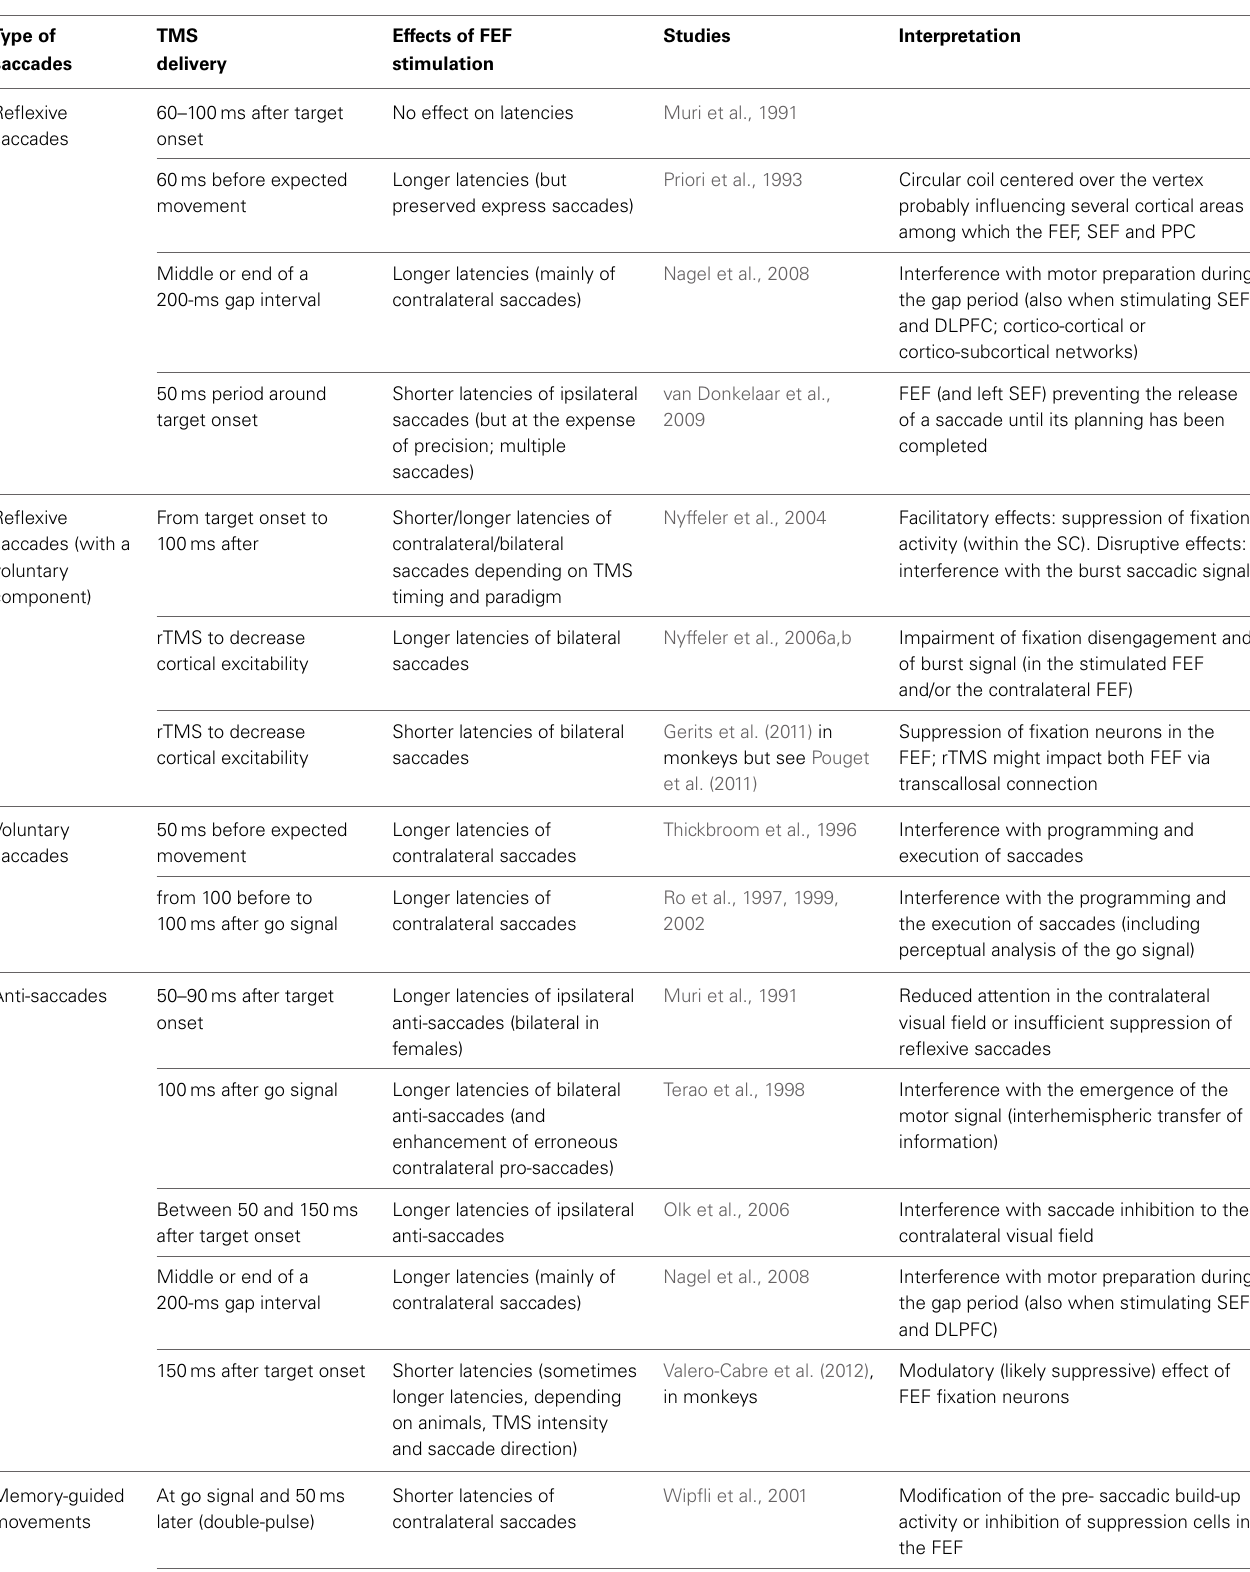
Table 5 | Effects of TMS over the FEF on eye